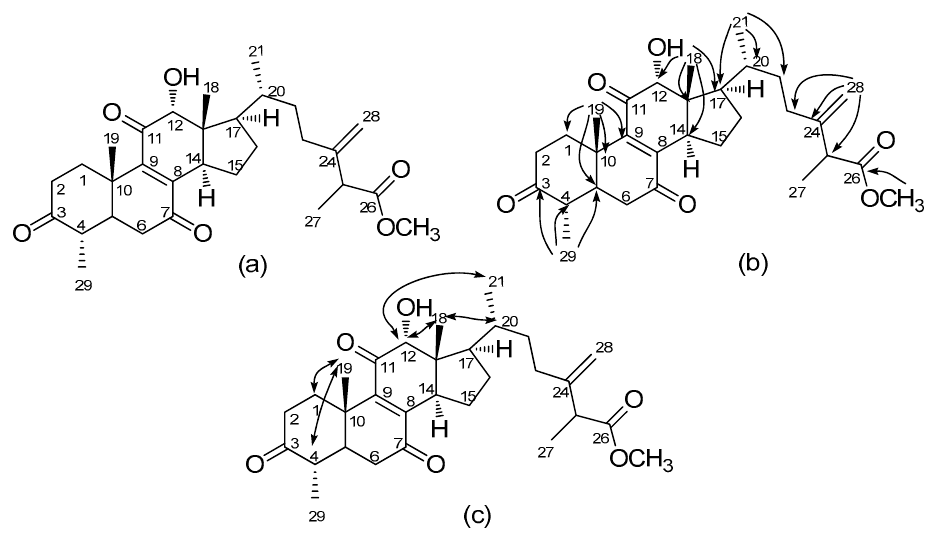
Figure 2. Structure of camphoratin N ( 2 ) ( a ) and its key HMBC ( b ) and NOESY ( c ) correlations.